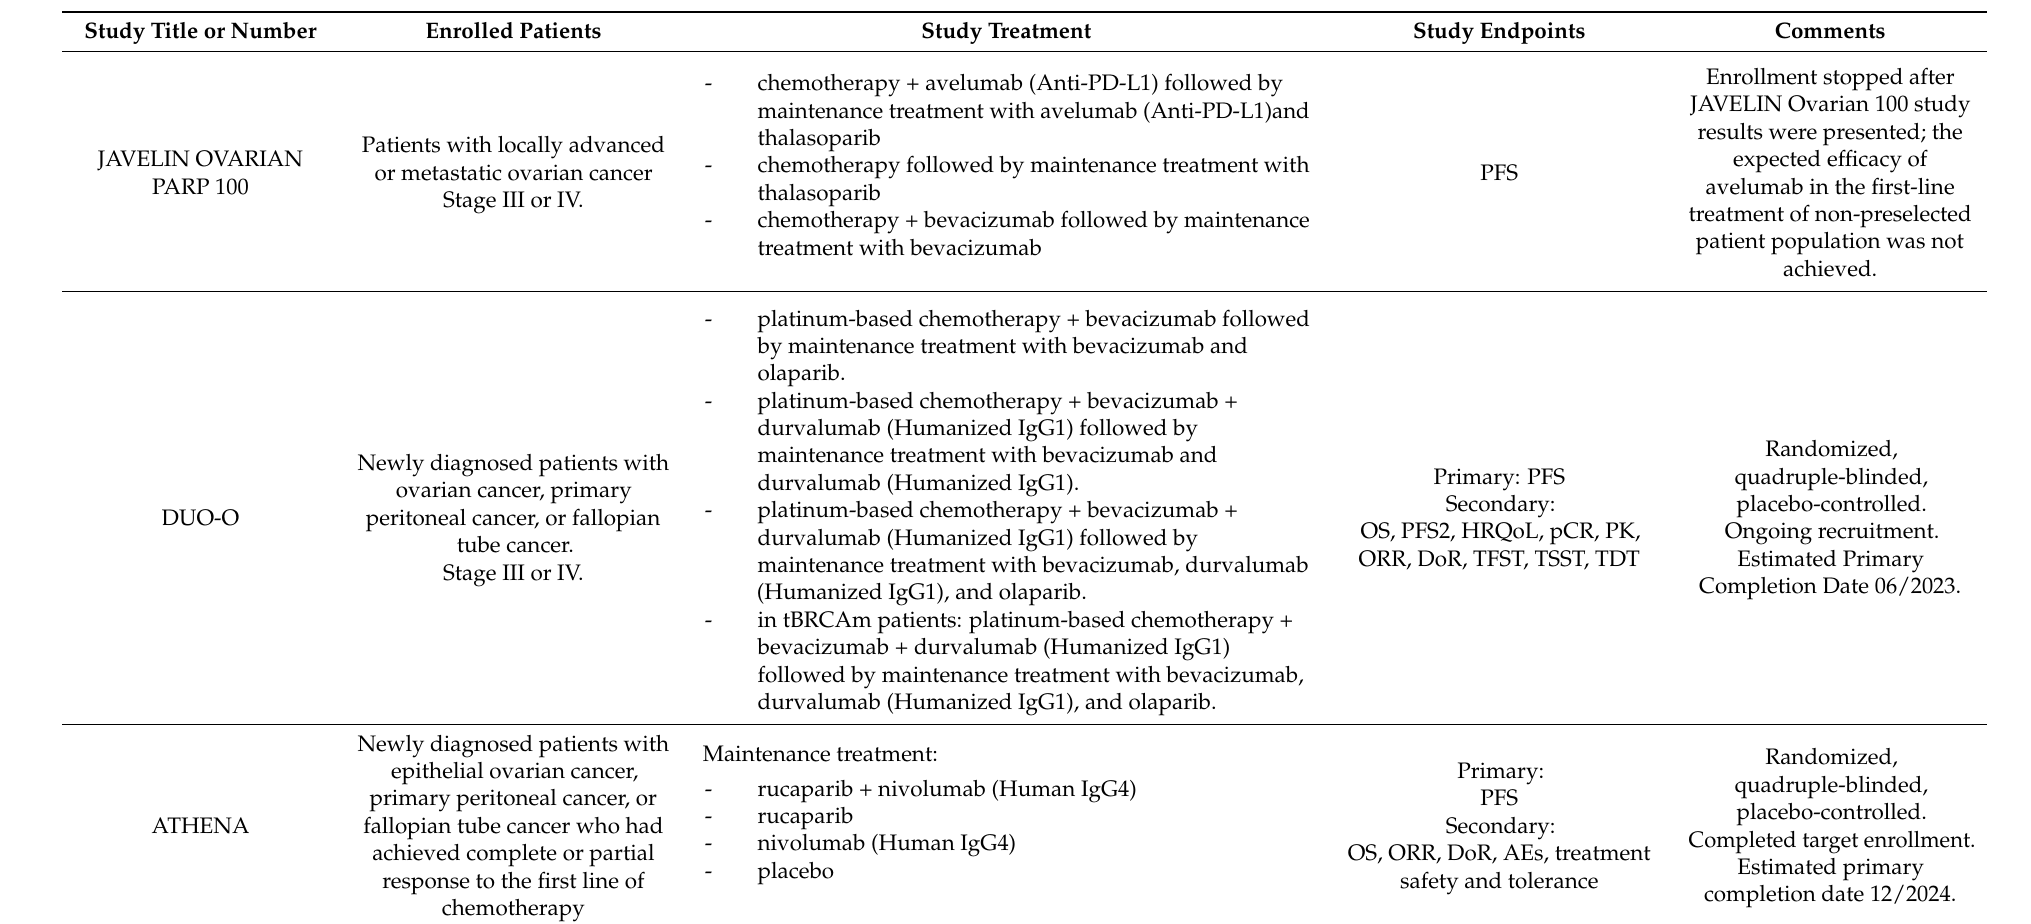
Table 3. Phase 3 clinical trials in patients with ovarian